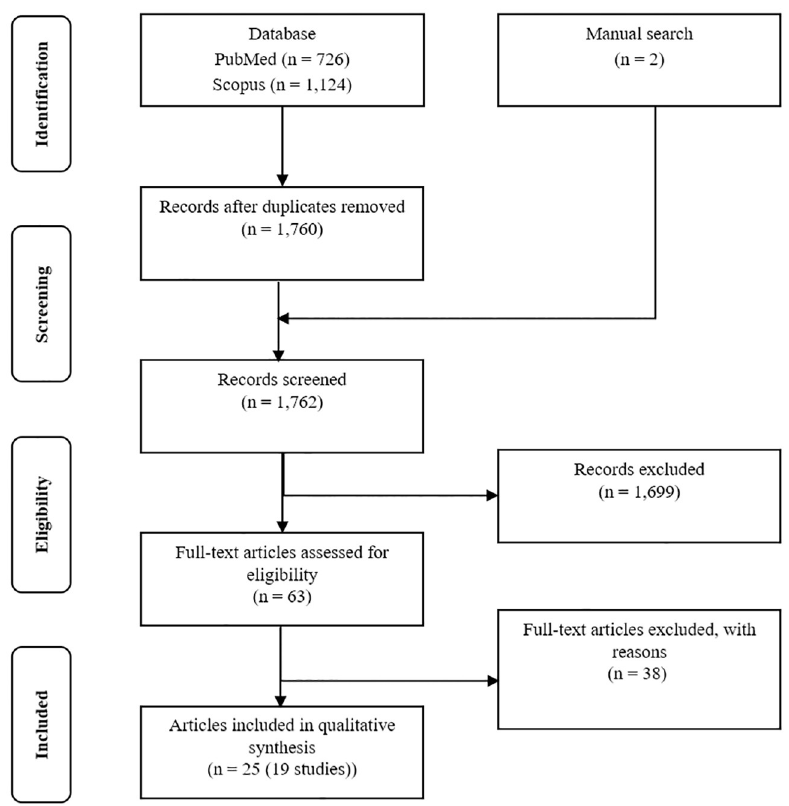
Fig 1. Study selection. The reasons are showed in supporting